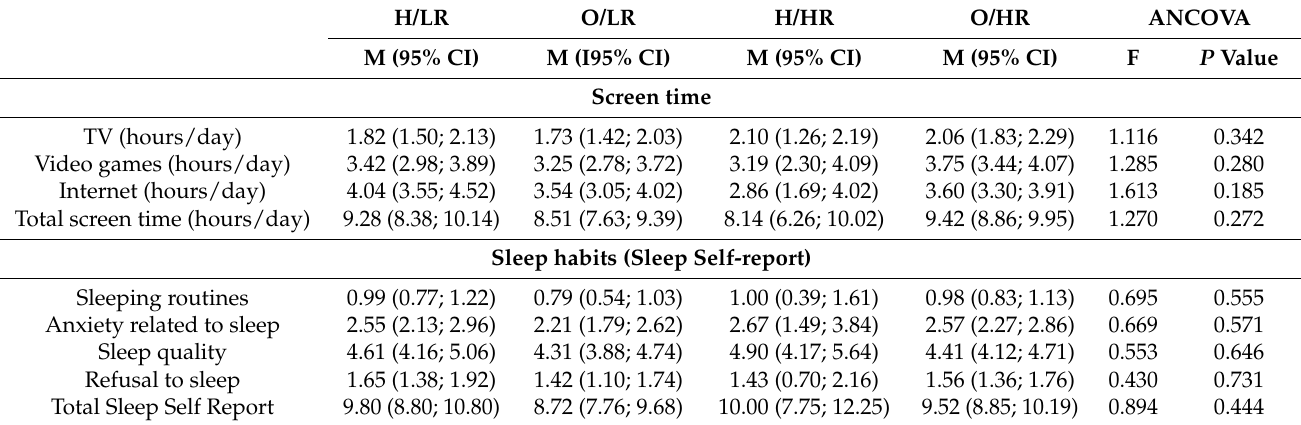
Table 4. Screen time, sleep habits, and physical fitness according to sub-classification of